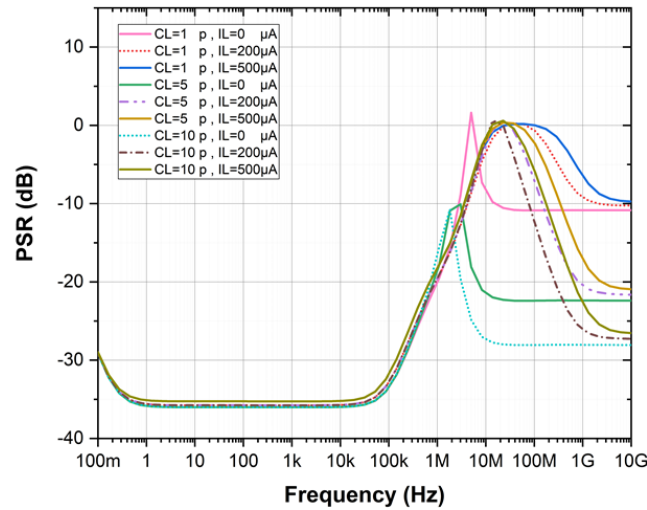
Figure 8. PSR of the Proposed Design at Different Capacitive Loads and Load Currents.